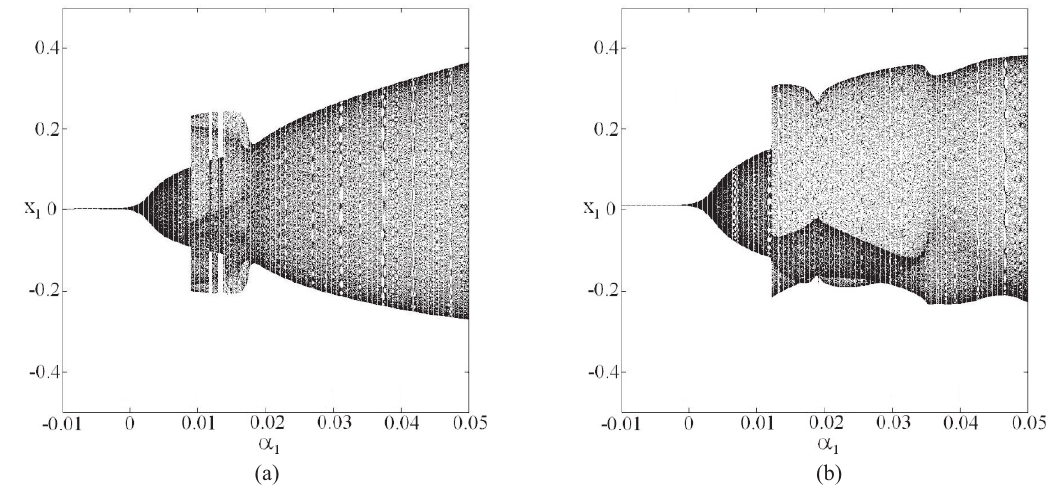
Fig. 12. Bifurcation diagrams of the beam response versus the self-excitation coefficient α 1 , (a) x 0 = 0.01, (b) x 0 = 0.02.